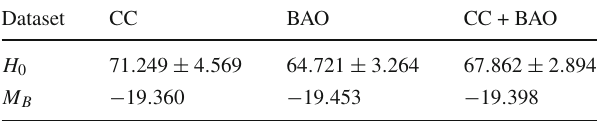
Table3 Tableshowingthereconstructedvalueof H 0 andbestfitvalues of M B for the Pantheon supernova data corresponding to the different H ( z ) datasets used in reconstruction